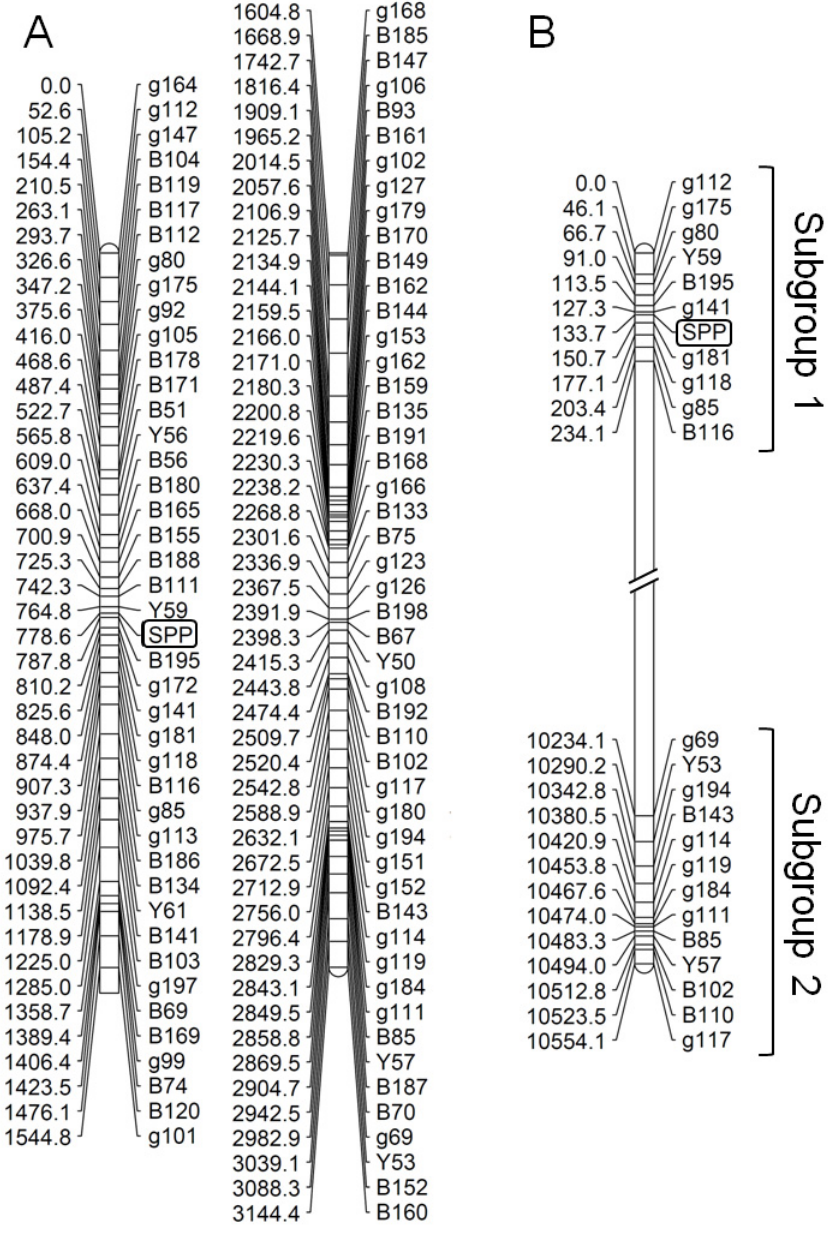
Figure A3. Linkage maps show the species-associated loci estimated by the maximum likelihood mapping algorithm using JoinMap ver. 4.0 [53]. Linkage group of species-associated loci estimated by criteria of ( A ) LOD 3.0 and ( B ) LOD 6.0 are shown. Two linkage subgroups at LOD 6.0 were inferred. The code SPP indicates the “character” as